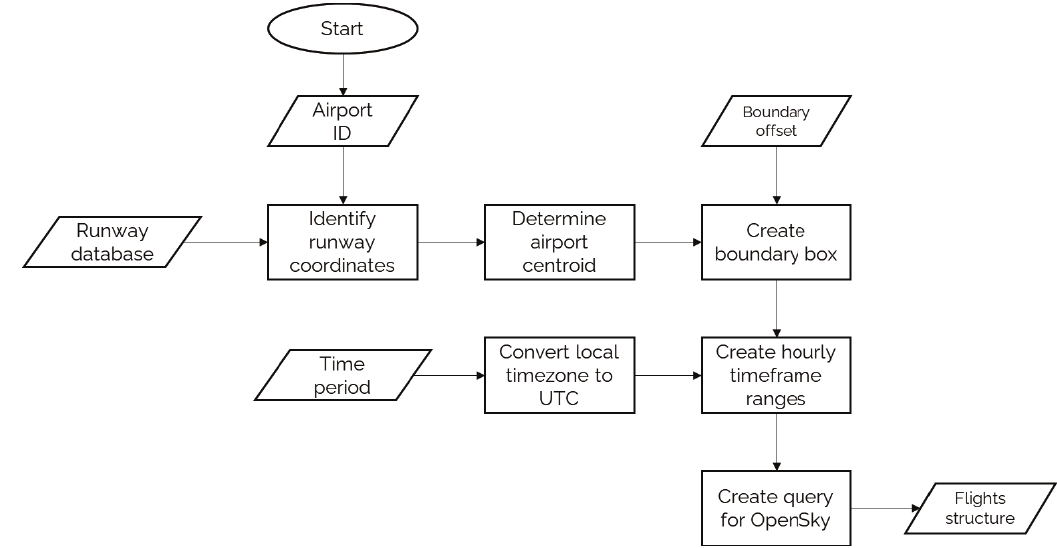
Figure 2. Th e process of automatically building and running a query for an airport relies on fi rst constraining the data temporally and geographically. Th e algorithm takes the airport ID and a time period as user inputs to build a boundary box and generate and run a query. Th e query results in the fl ights structure, which contains all transmissions received during the specifi ed time in the boundary box, and is used by the Operations Counter post-processing algorithm to count the number of takeoff s and